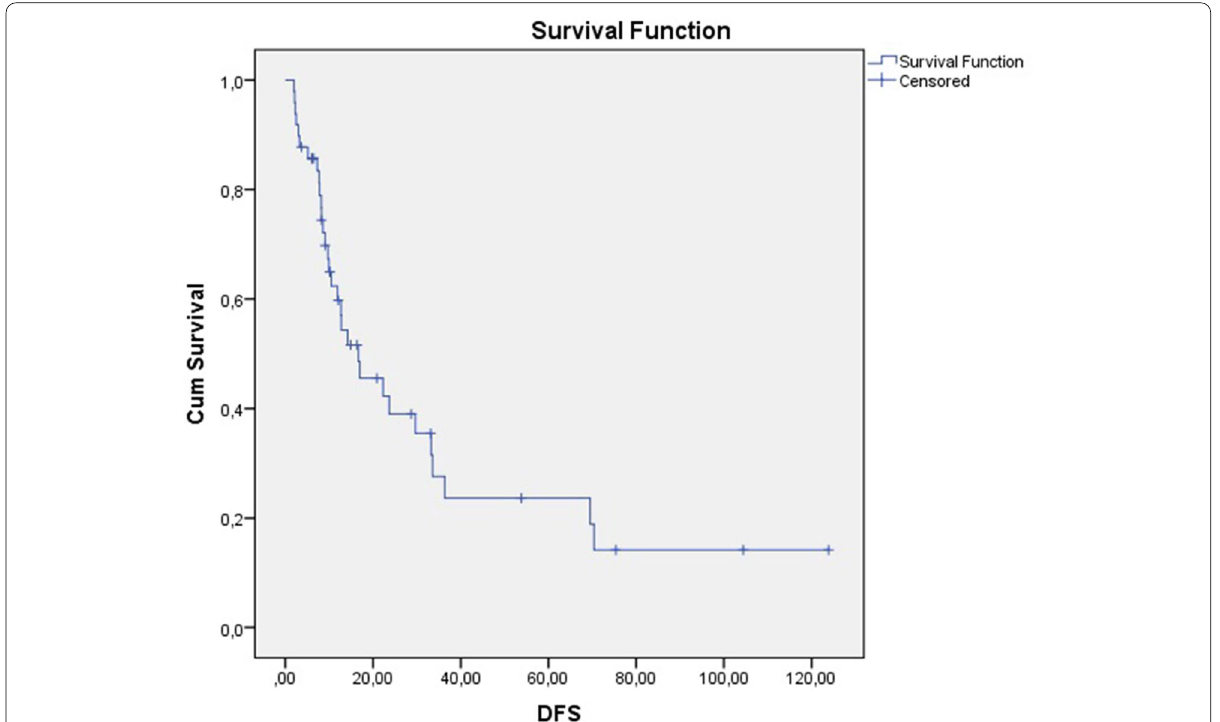
Fig. 1 Kaplan–Meier curve of DFS for all